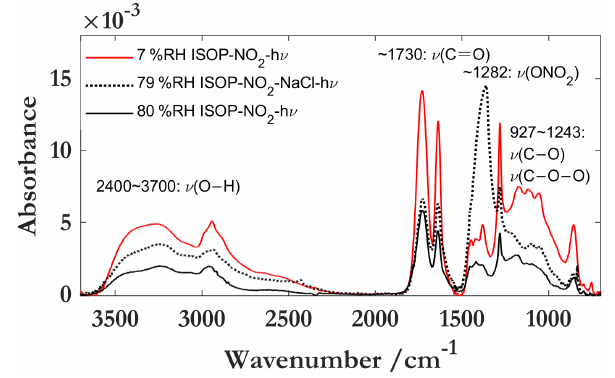
Figure 6. Infrared spectra of SOA from isoprene irradiations under dry and humid conditions. The bands at 1636, 1282, and 855cm − 1 are from ONO 2 . The bands at 1170 and 1121cm − 1 are assigned to C–O–C in oligomers or C–O in carboxylic acids, and the band at 1055cm − 1 is from alcohols. The absorption shoulder from 927 to 1080cm − 1 is assigned to C–O and O–O in the peroxide group (C–O–O) (Pretsch et al.,